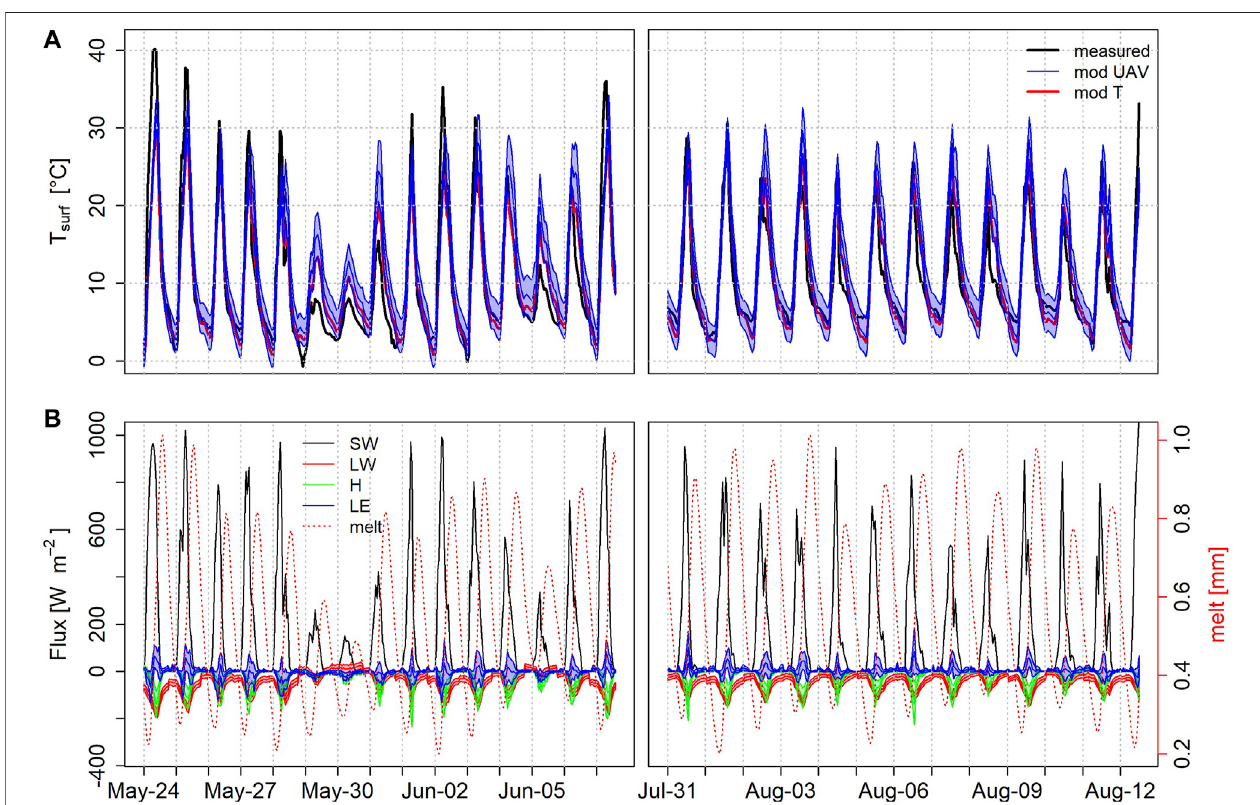
FIGURE 8 | Measured and modeled surface temperature of the debris at the AWS, with ‘ mod UAV ’ denoting the results that fi t best with the UAV mass loss measurementand ‘ modT ’ those fi ttingbestwithobservedsurfacetemperature (A) .Resulting(net) fl uxesandmeltratesbasedonthemodel (B) .Theshadedareashows the range of results based on the 25 best performing model runs after comparison of the modeled mass loss with the measured mass loss ( Figure 7 ).